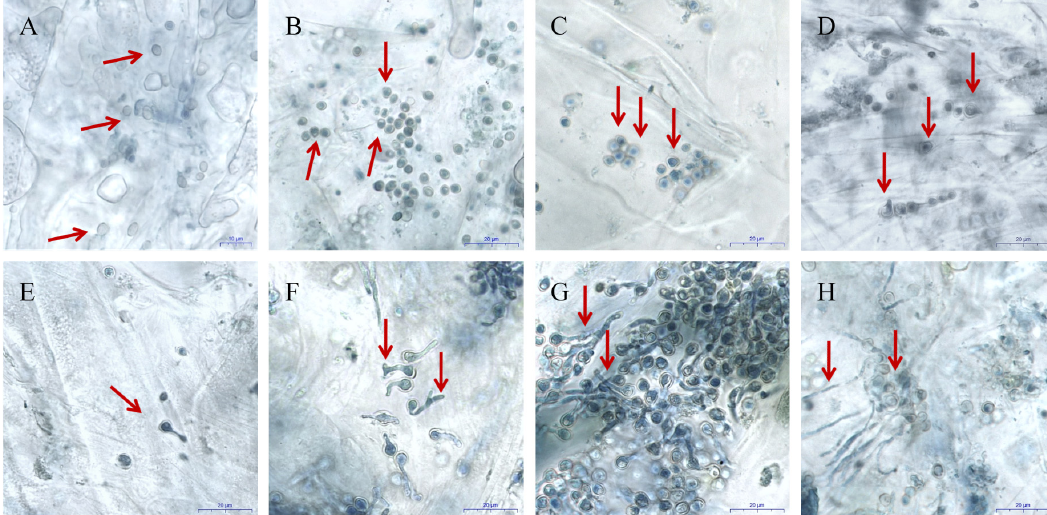
Figure 1. Microscopic images of the activation, germination, and growth of P. expansum spores and germ tubes at 25 ◦ C in wounded apple fruit tissue. ( A – C ) P. expansum spores in wounded apple tissue at 0, 1, and 3 h post-inoculation (hpi). ( D , E ) P. expansum spores and germ tubes at 6 hpi. ( F , G ) P. expansum spores and germ tubes at 9 hpi. ( H) Spores, germ tubes and young mycelia of P. expansum in wounded apple tissues at 12 hpi. Scale bar represents in A–H represents 20 µ m. Red rows represent the